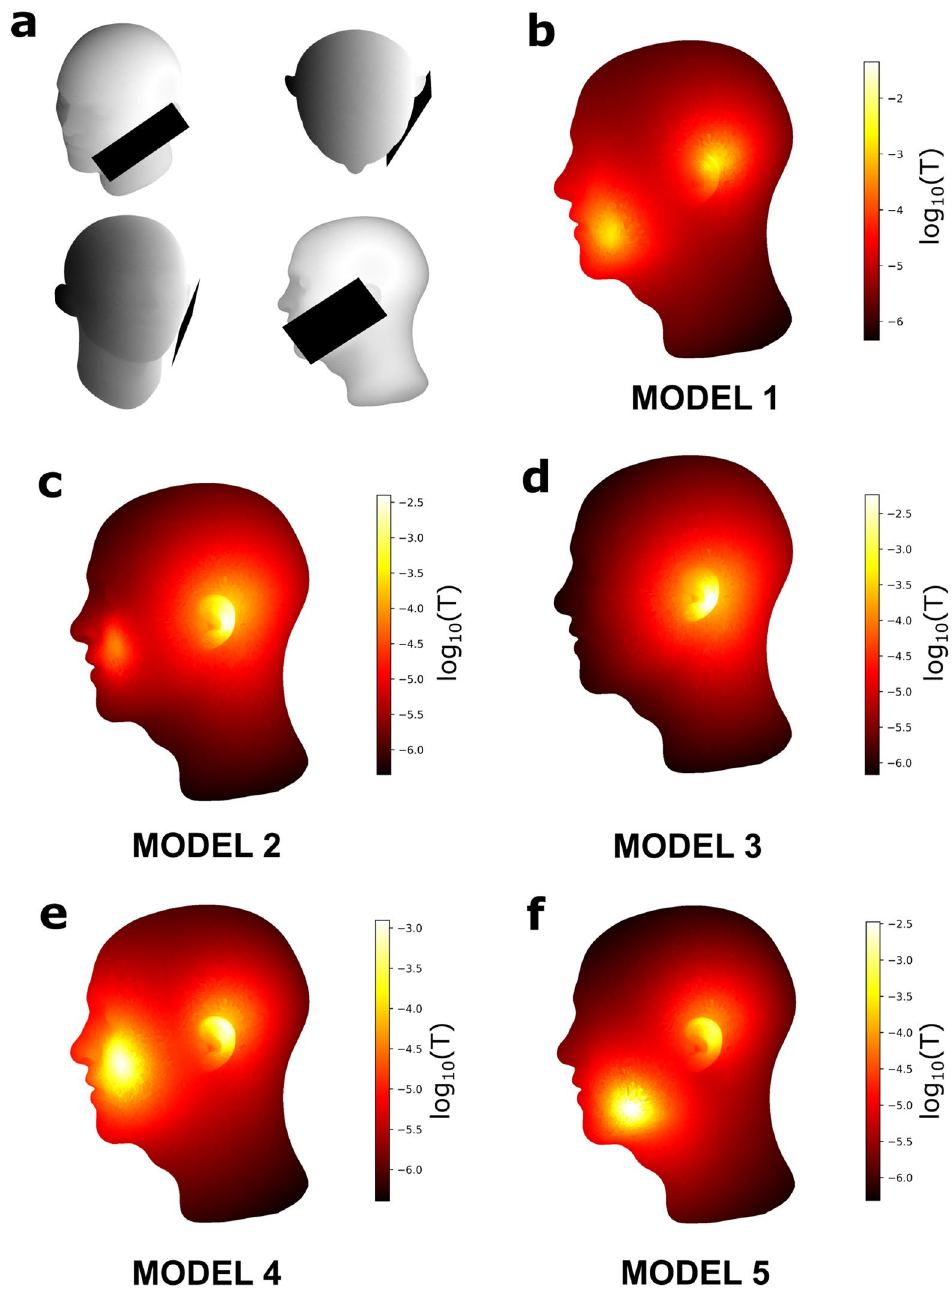
Figure 5. ( a ) Location of the phone (shades of gray are only lighting, not magnetic field data). ( b – f ) Magnetic field distribution on the head model according to the simulations (fitted to the